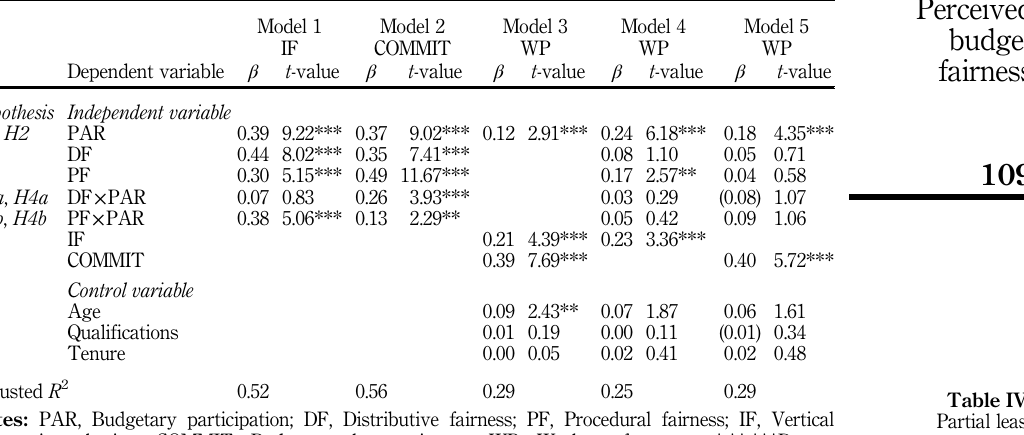
squares results for theoretical